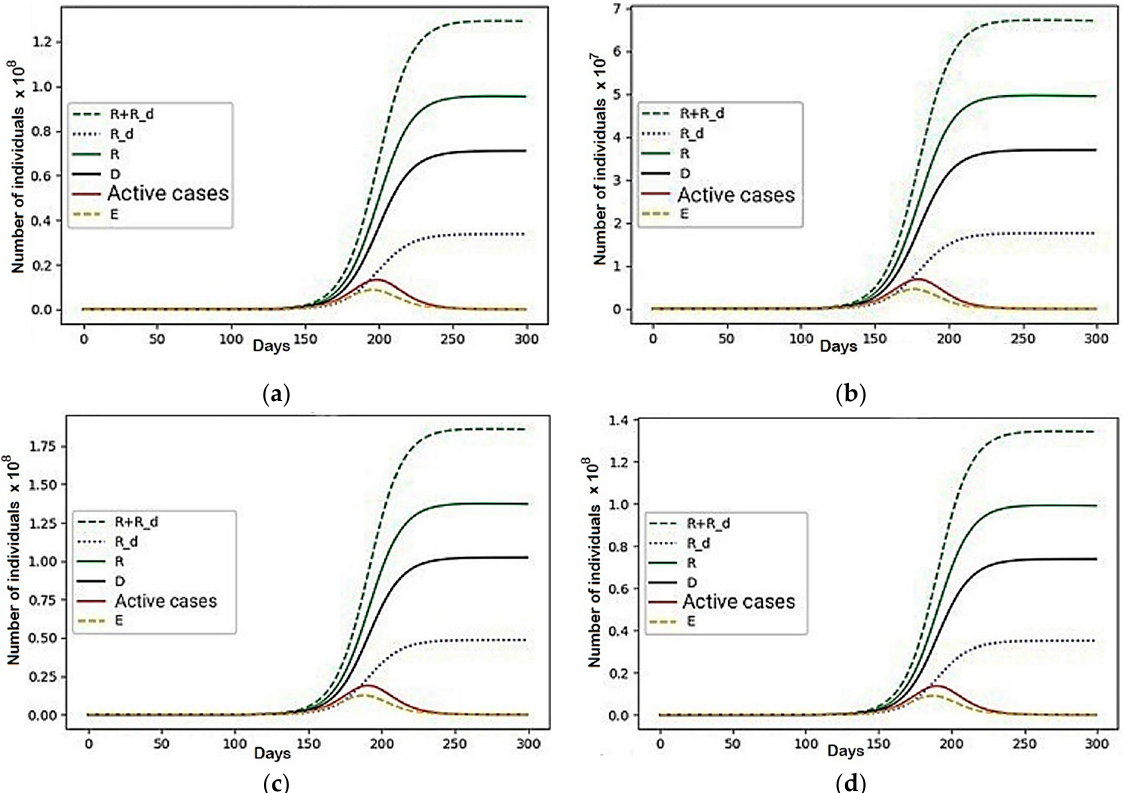
Figure 3. A scenario in which all the coefficients 𝑎 (cid:3041) , 𝑏 (cid:3041) ,с (cid:3041) , 𝑑 (cid:2869) , 𝑑 (cid:2870) , 𝑛 = 1,2, 3, 4 are equal to zero: ( a ) Region 1; ( b ) Region 2; ( c ) Region 3; ( d ) Region